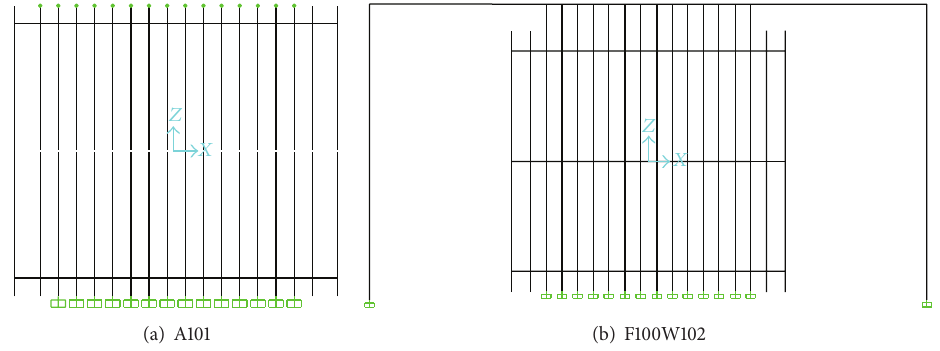
Figure 14: Simplified analytical models of two specimens.